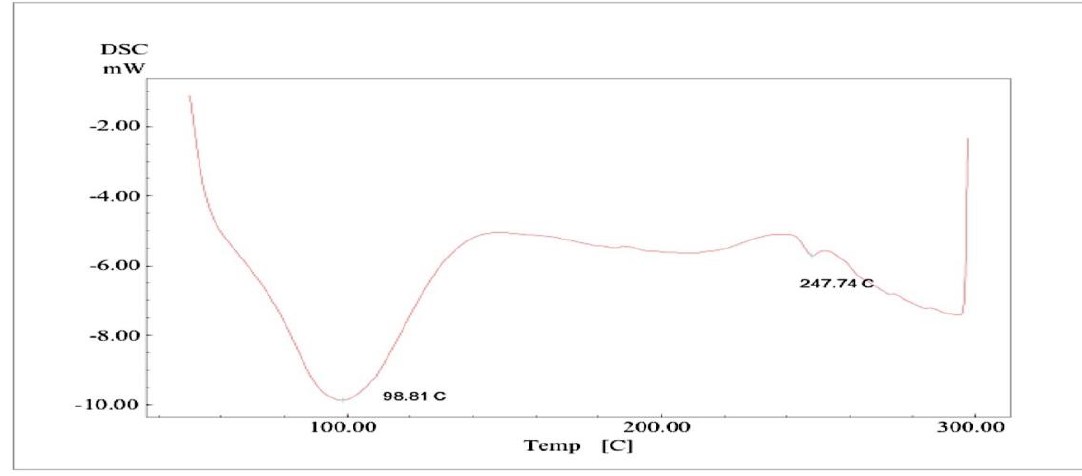
In-vitro dissolution study of domperidone nanoparticles form capsule dosage form The percentage of drug release at15min and the time required for released 100% of drug were considered for the comparison of the dissolution results between pure and